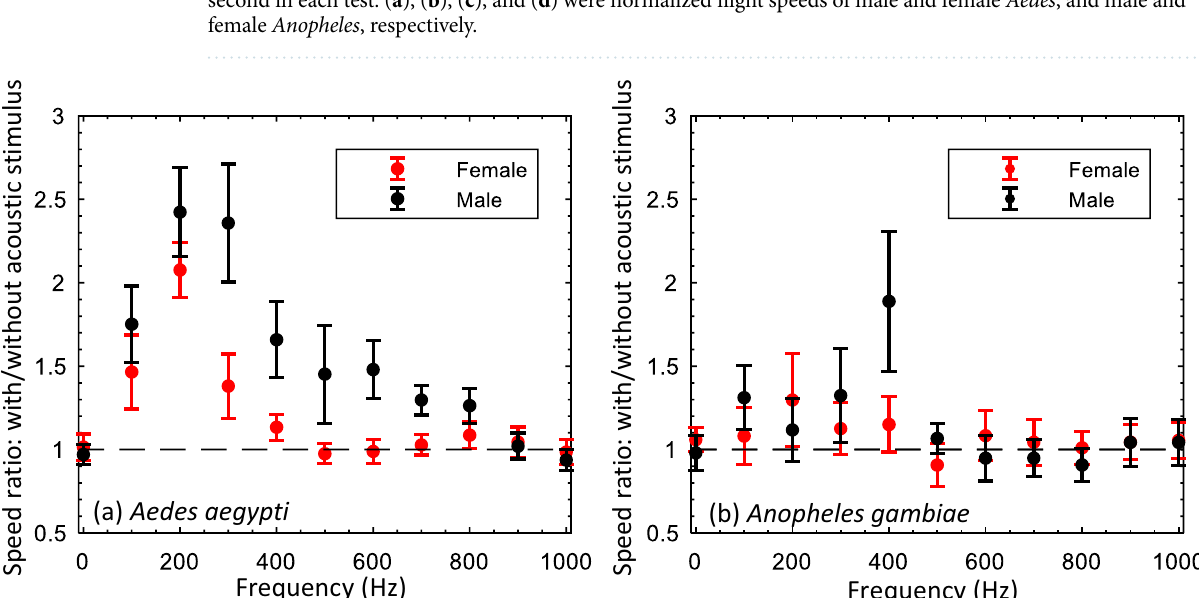
Figure 2. The ratio of mosquito flight with/without acoustic wave at different acoustic frequencies at a fixed sound intensity of 103 dB. ( a ) Aedes and ( b ) Anopheles